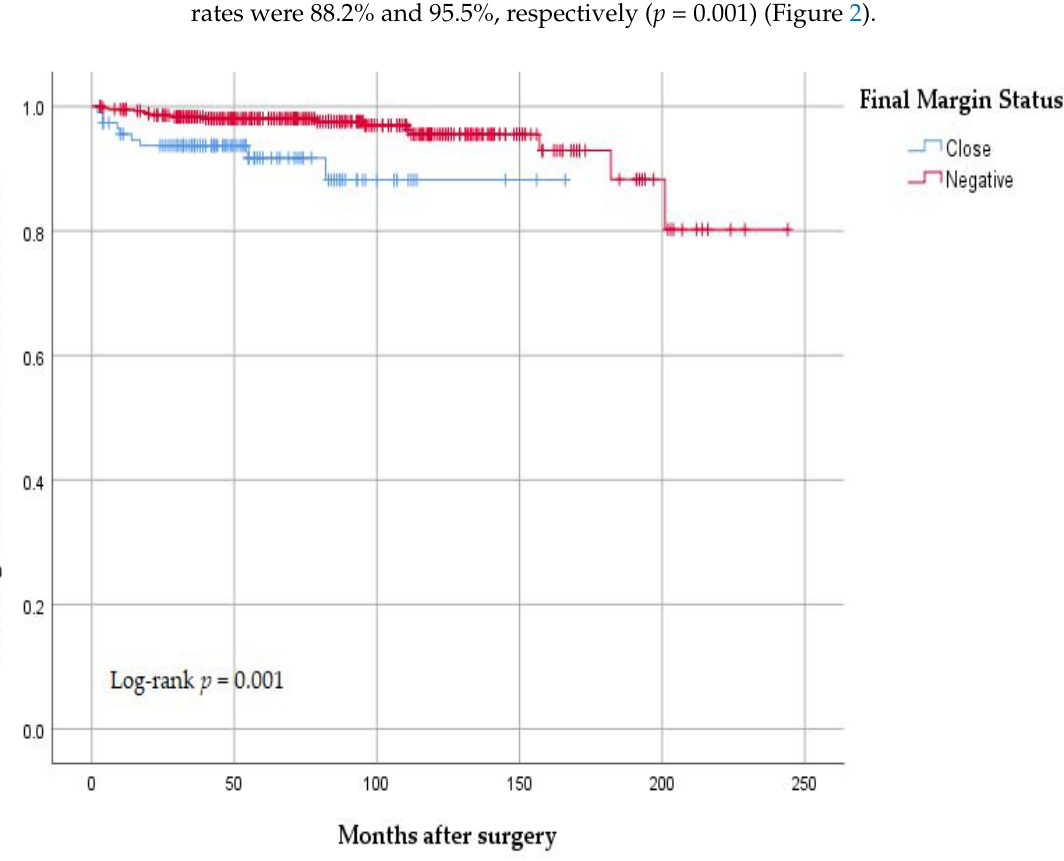
Table 3. Cox proportional hazard model of risk factors associated with locoregional recurrence. Variables